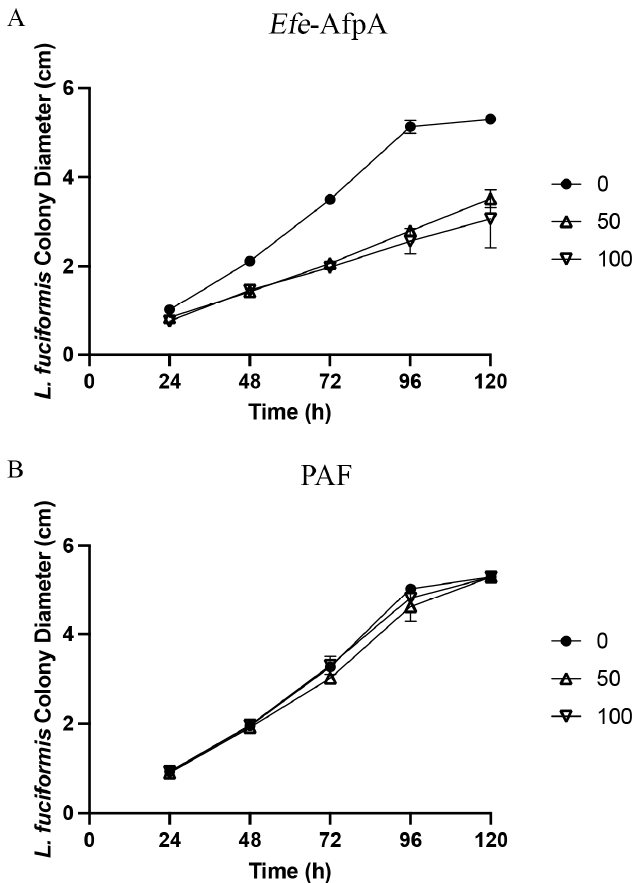
Figure 6. Activity of ( A ) Efe -AfpA and ( B ) PAF against L. fuciformis mycelial growth. L. fuciformis mycelial plugs were subcultured onto PDA plates amended with increasing concentrations of Efe -AfpA or PAF. The colony diameters were measured daily. The data presented are the means and standard deviations of three replicates.